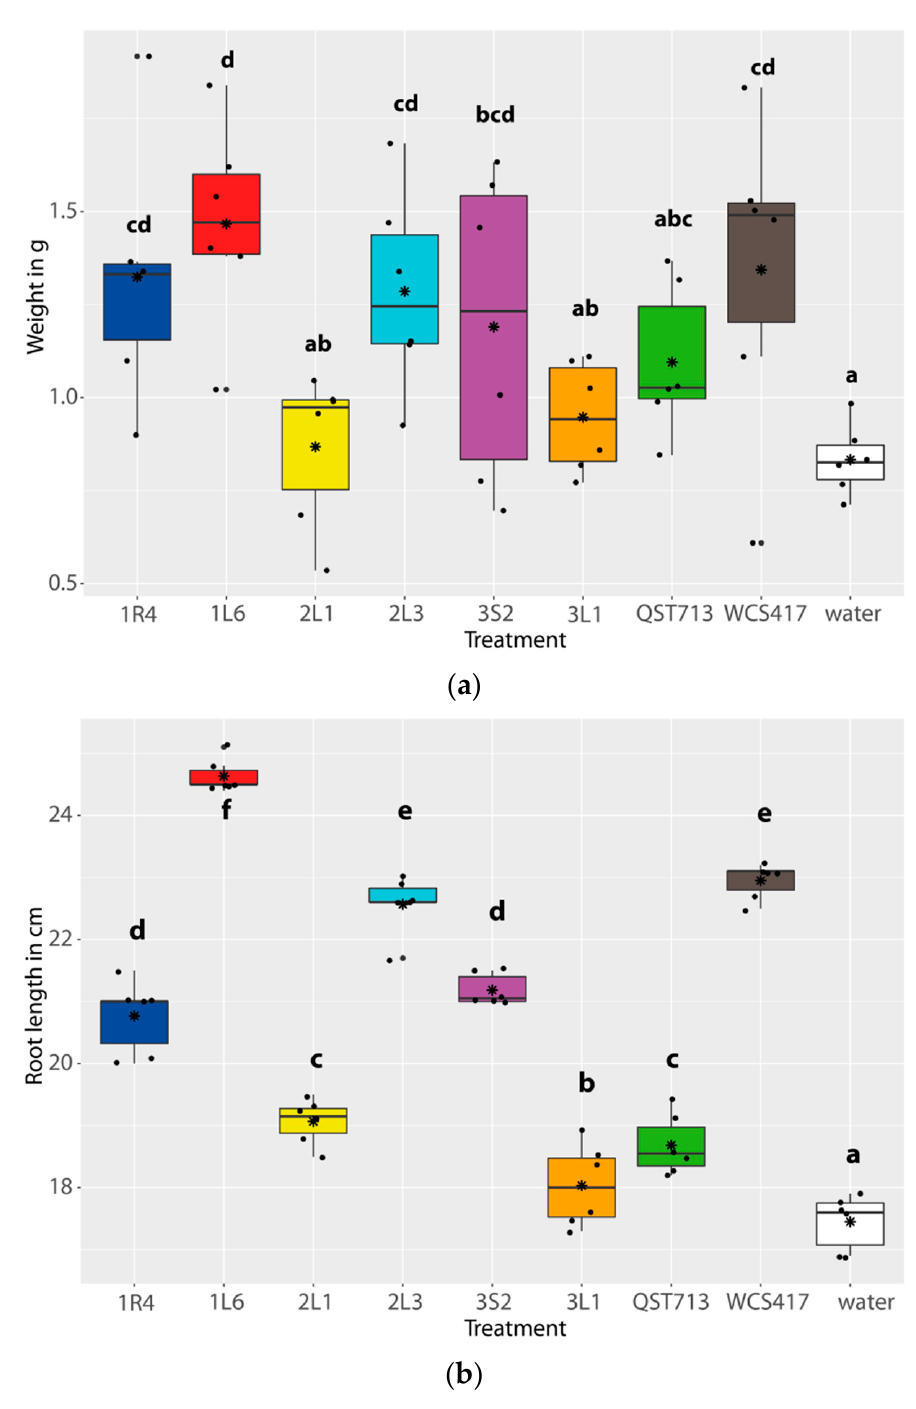
Figure 3. Boxplot of plant growth promotion ability of selected endophytic isolates from rapeseed and reference strains of PGP bacteria: ( a ) weight of seedlings 14 days after spray inoculation; ( b ) length of roots 14 days after spray inoculation. Boxes indicate 1st and 3rd quartiles, horizontal line is median, asterisk is average, whiskers indicate 1.5 times theinterquartile range, and dots are data points. Boxes accompanied with the same letter are not significantly different at α = 0.05 according to Fisher LSD test.